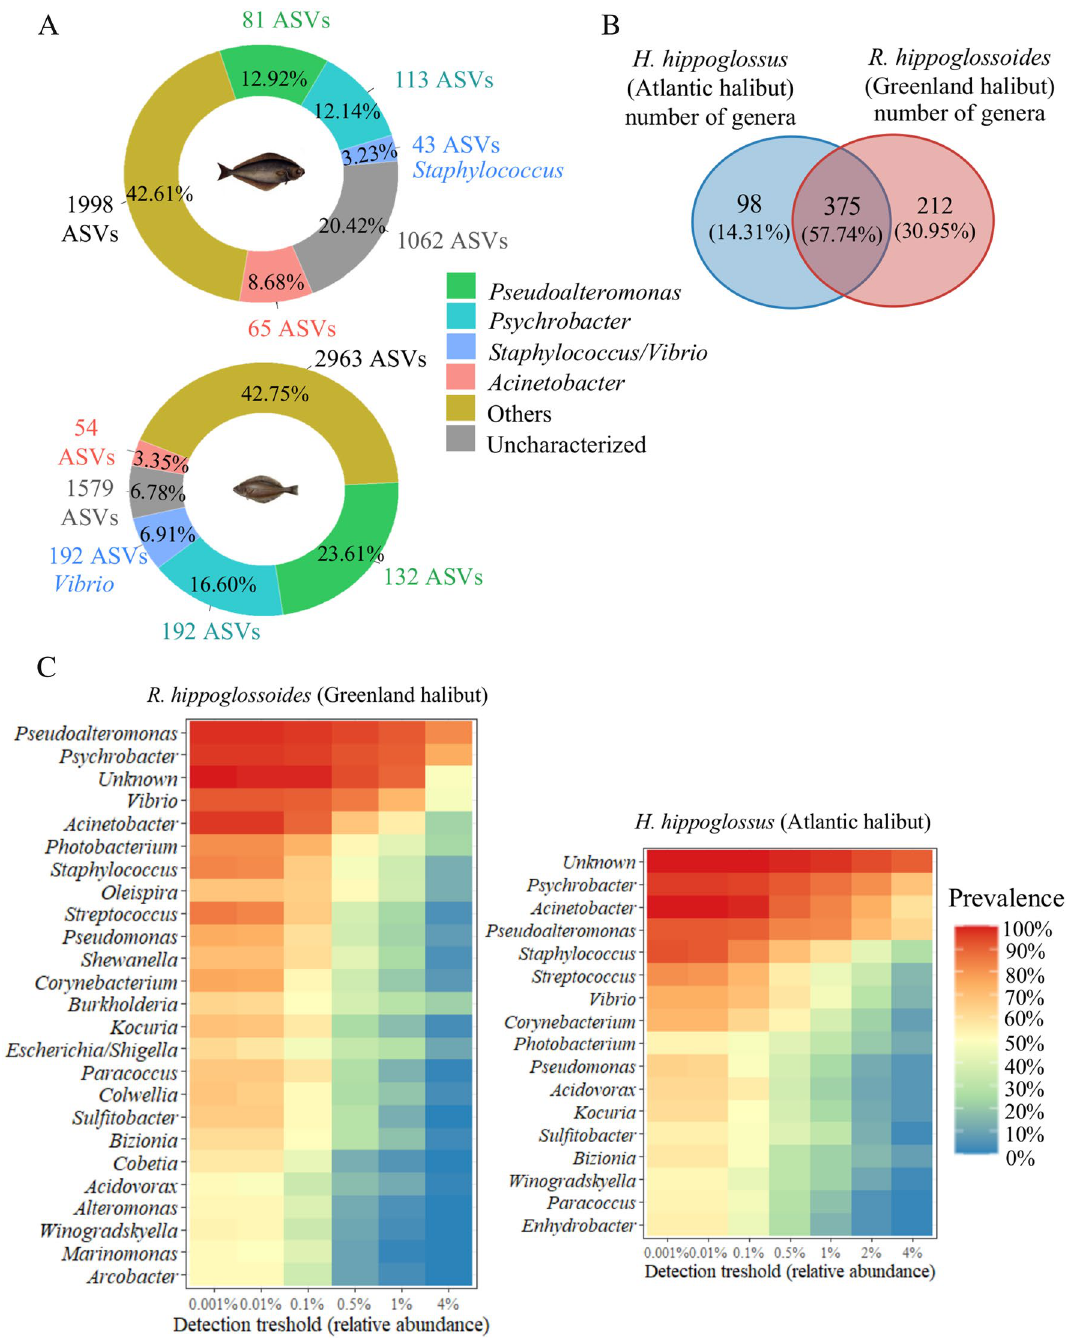
Figure 3. Core blood microbiome analysis. ( A ) Mean relative abundance (%) of the core genera aggregated (90% prevalence) in the cmDNA of the blood microbiome of the Atlantic halibut ( H. hippoglossus ) (top) and the Greenland halibut ( R. hippoglossoides ) (bottom). The mean relative abundance is given in each pie chart, and the number of aggregated ASVs is indicated next to each pie chart. ( B ) Venn diagram showing common and distinctive genera in the blood microbiome. ( C ) Heatmaps of the core microbiome. These heatmaps identify the most prevalent bacteria in both halibut species. Atlantic halibut, n = 86, Greenland halibut, n =